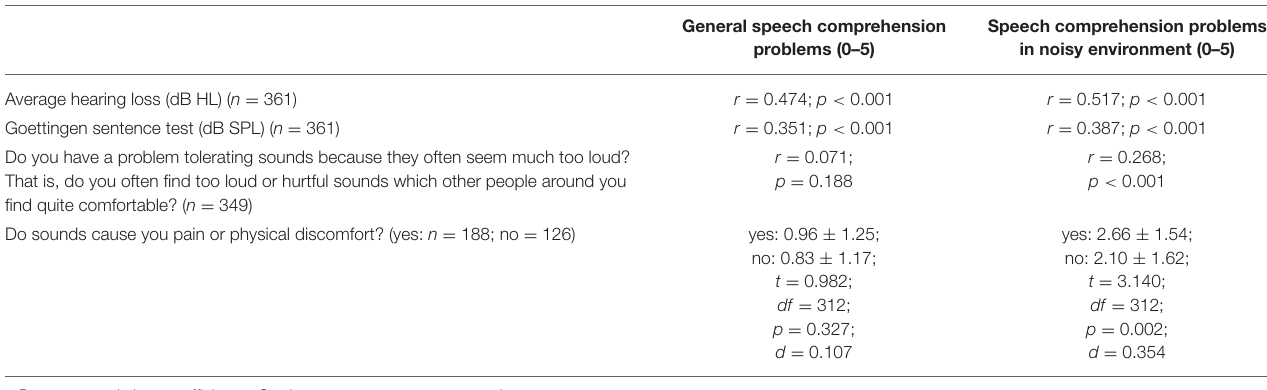
TABLE 1 | (A) Association of variables of audiometry, Goettingen sentence test, and hyperacusis with subjective speech comprehension.